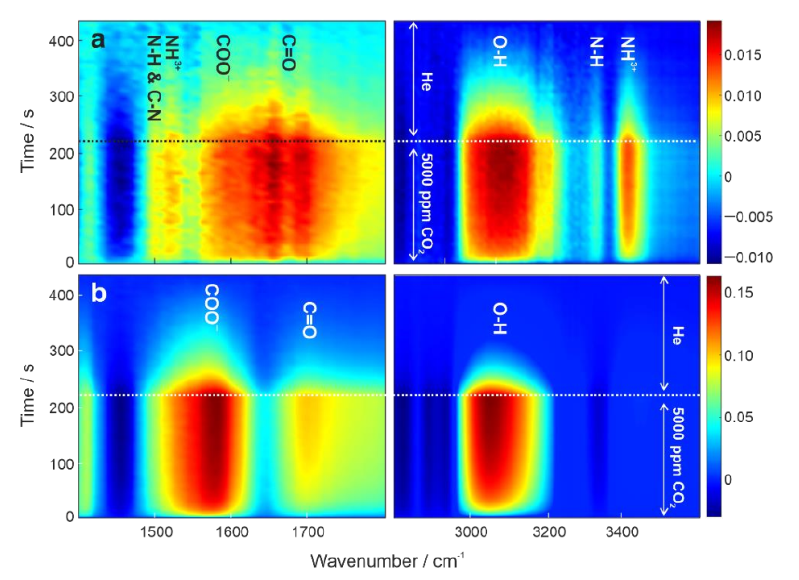
Figure 3. Time-domain IR contour plots of ( a ) 30 wt % BPEI/SiO 2 and ( b ) 30 wt % LPEI/SiO 2 during CO 2 adsorption–desorption at 50 ◦ C (5000 ppm CO 2 in He balance: 200 mL/min, pure He: 200 mL/min). The unit of the color bar is absorbance.